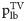
Pressure-volume curve for trumpet lobule.Lobular volume Vlb in function of the elastic pressure pel as defined in Eq 3. The purple area indicates the reference pleural pressure range plbTV and the orange area indicates the nominal lobule volume range [Vlb0,Vlb0+VlbTV]. In panel (a) the influence of the compliance modification parameter ϕ∈[0.5,1.5] is shown. For lobules with normal compliance (ϕ = 1, solid line) the elastic pressure curve intersects in the point (plbTV,Vlb0+VlbTV). In panel (b) the effect of the non-linear parameter γ is shown. The parameter was chosen such that the elastic pressure curve intersects with the point (14plbTV,Vlb0+34ϕVlbTV) (black dot). Note that ϕ = 1 was used for all graphs in panel (b).